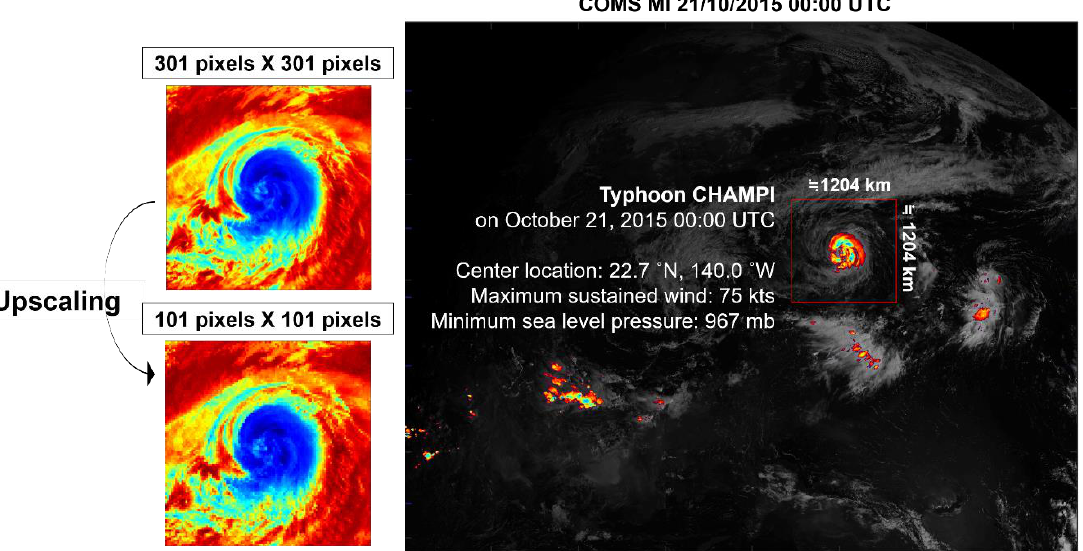
Figure 1. COMS MI data-based tropical cyclone image extraction. The images are extracted with a 301 × 301 pixel rectangle corresponding to 124 km by 124 km based on the tropical cyclone center location. The images are upscaled to 101 × 101 pixels to reduce computational demand. Since tropical cyclones are larger scaled phenomena than cloud clusters, tropical cyclone patterns, such as spiral rain bands or eyewall strength pattern, clearly appear in the upscaled images.